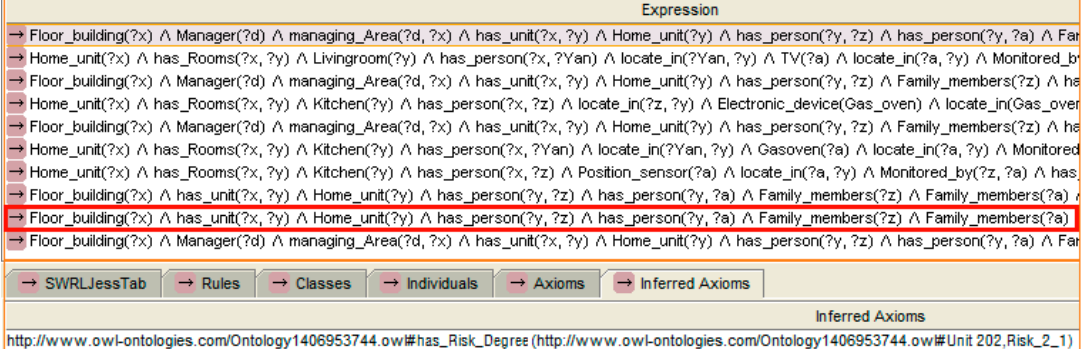
Figure 24. Remote control of the electronic device in SH. The sampling algorithm of the sensor network is designed in such a way that it only sends the data to the remote server when there is a change. Otherwise, it sends it every 10 min. Adding time thresholds has a different significance for each type of sensor node but one common benefit is that, by this, the system identifies the dead and malfunctioning nodes in the network. A computer is used as the remote server. The data from local end-nodes is transmitted to a coordinator connected in a home gateway. Then, a data packet is transmitted to the remote server through a base station. The data is processed and relevant contextual information is extracted by the ontology middleware in the remote server. The local SH only collects and communicates data. The task of analysing information to determine daily living activities and context-aware scenarios is performed by the remote server. Processed data is uploaded to a database which is directly mapped to the ontology. This is suitable for the centralised management of SHs in a large neighbourhood. Service tasks such as assigning a manager to provide manual service could be set up and performed immediately. The experiments concern the recognition of risk situations simulated by three groups of candidates who perform relevant activities. For example, a candidate opens the oven and leaves the kitchen without anybody in it. In this case, the candidate should perform the activity of cooking and leave the kitchen. The situation is simulated respectively by three groups of candidates. Each situation is performed on schedule. Some typical cases (but not all) are listed in Table 6. A total of